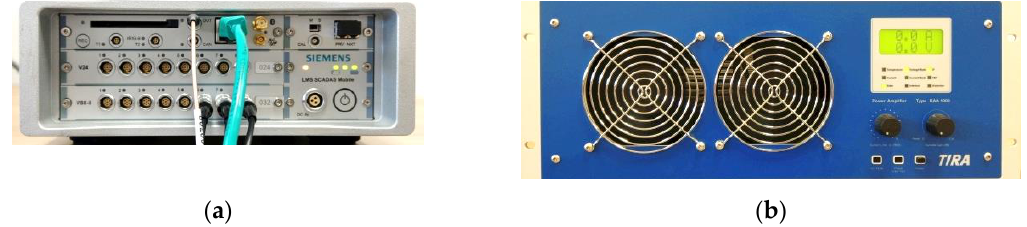
Figure 2. Multichannel 24-bit data acquisition hardware type SCADAS Recorder from SIEMENS (Plano, TX, USA) ( a ) and TIRA signal amplifier ( b ) (TIRA GmbH, Schalkau, Germany).